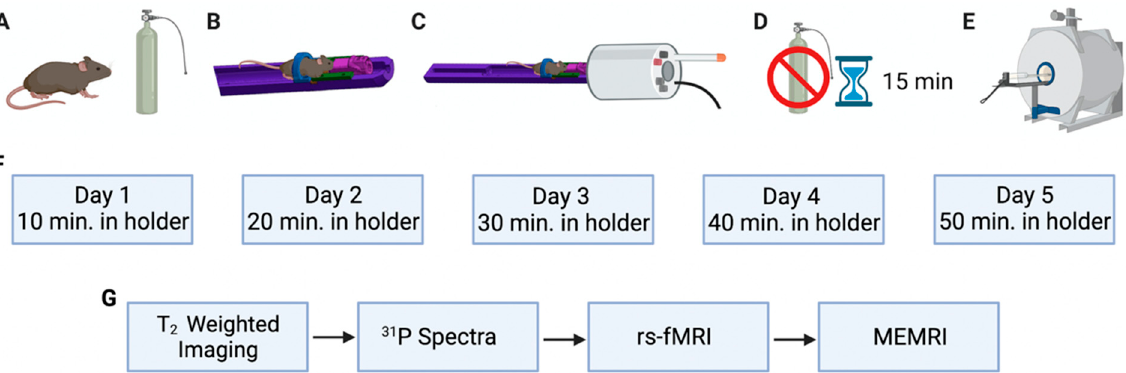
Figure 3. Protocol for 5-day acclimation for awake mouse imaging ( A – F ). Protocol for awake image acquisition ( A – E , G ). Mice were lightly anesthetized under 0.5–1% isoflurane with a flow rate of 2.5 L/minute for approximately 2 to 3 min ( A ). Mice were secured into the holder with a continued delivery of 0.5–1% isoflurane and maintained at 37 ◦ C with an air-heating system ( B ). The mouse holder was slid into coil ( C ), isoflurane was discontinued, and mice were given 15 min to become fully awake ( D ). EPI noises, conduct T 2 Tripilot, and Anatomy 2b scans were run ( E ). Mice remained in the MRI for set amount of time based on day of acclimation (physiological responses to stress are monitored throughout) ( F ). After Day 5 of acclimation T 2 ‐ weighted imaging was conducted (T 2 Tripilot position scan was conducted first and animal was adjusted if necessary), 31 P and T 1 ‐ weighted MEMRI studies were conducted, and rs ‐ fMRI data collected ( G ).